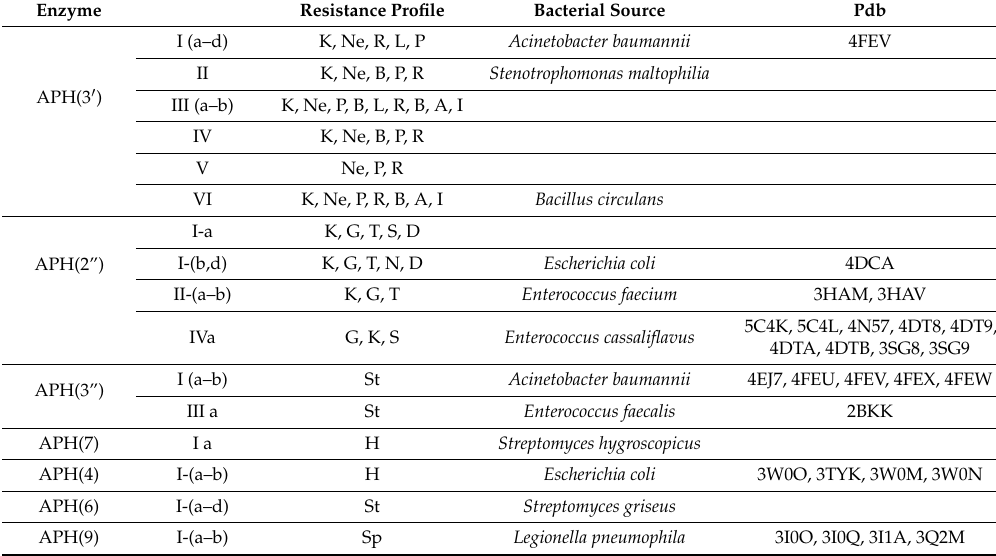
Table 2. O -phosphotransferase (APH)-modifying